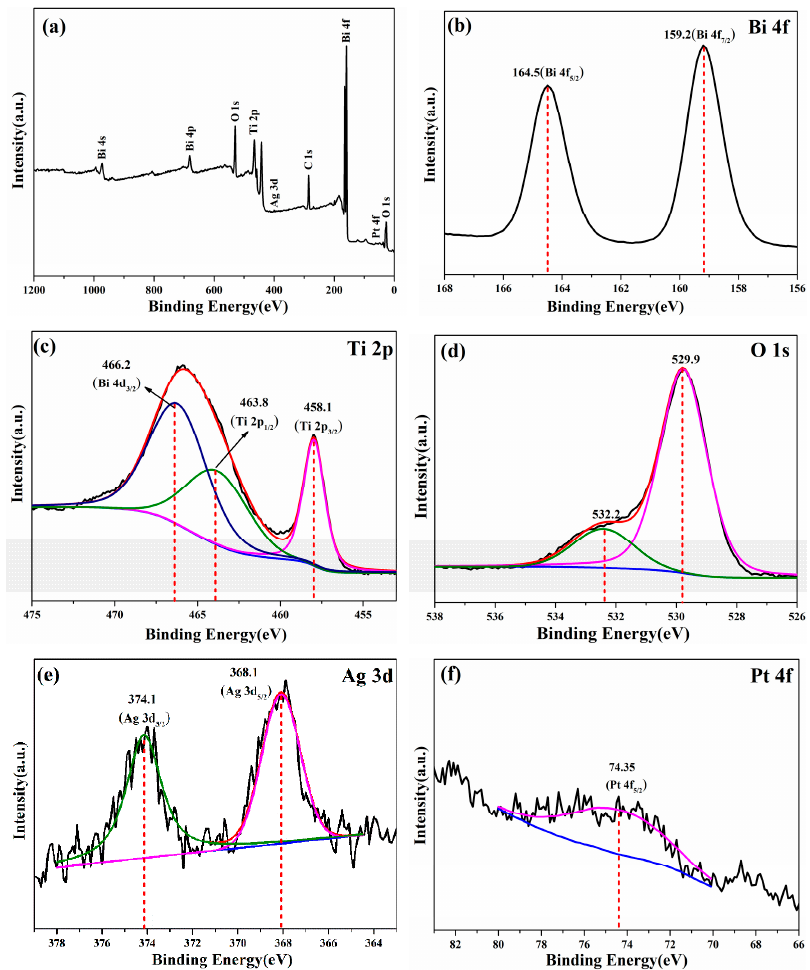
Figure 7. ( a ) X-ray photoelectron spectroscopy (XPS) survey scan spectrum and ( b – f ) high resolution XPS spectra of Bi 4f, Ti 2p, O 1s, Ag 3d and Pt 4f of (Ag 0.7 Pt 0.3 ) 0.001 / Bi 4 Ti 3 O 12 .